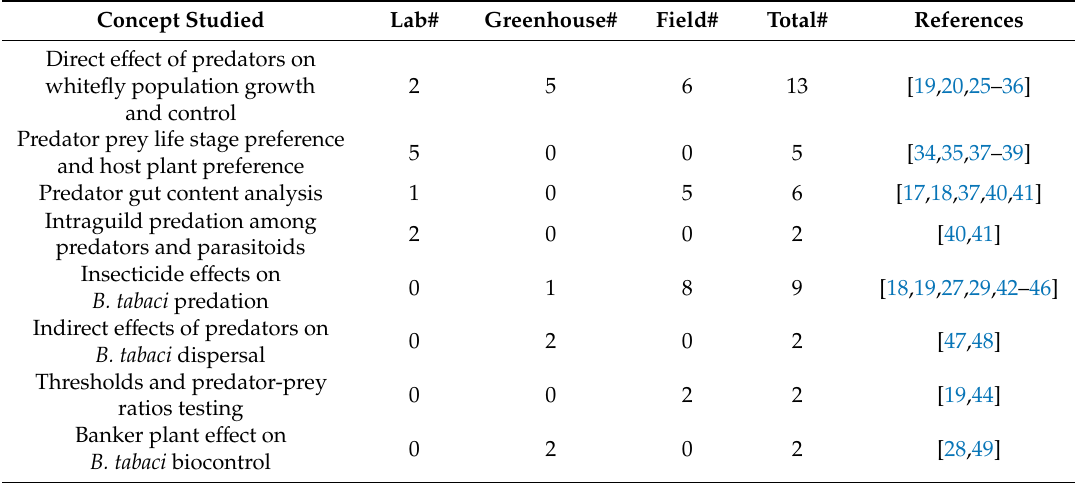
Table 1. Summary of studies focused on predators and whitefly ( Bemisia tabaci )